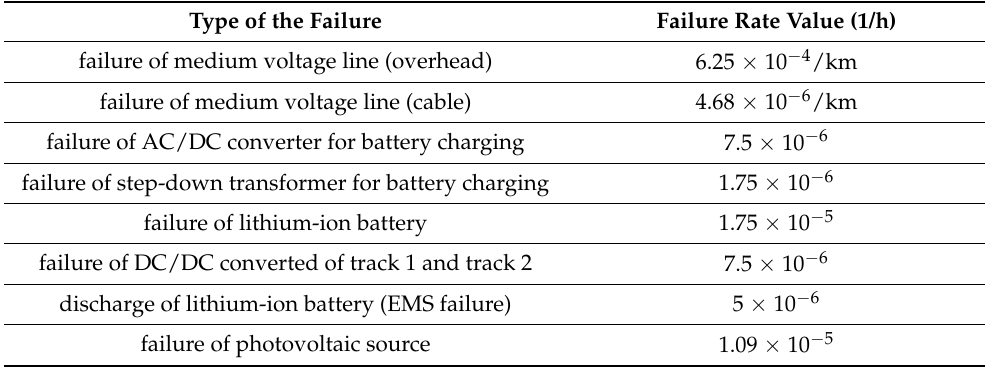
Table 7. The assumed values of failure rate of each element of the analyzed power supply structure. Type of the Failure failure of medium voltage line (overhead)